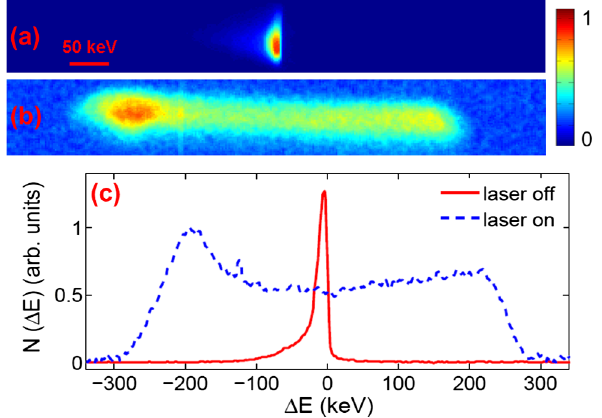
and laser on (b) at 120 MeV (corresponding to the 3rd harmonic interaction). The beam intensity in (a) is reduced by a factor of 10 to avoid saturation using the same scaling as (b). The projections of beam energy distributions in (a) and (b) are shown in (c).